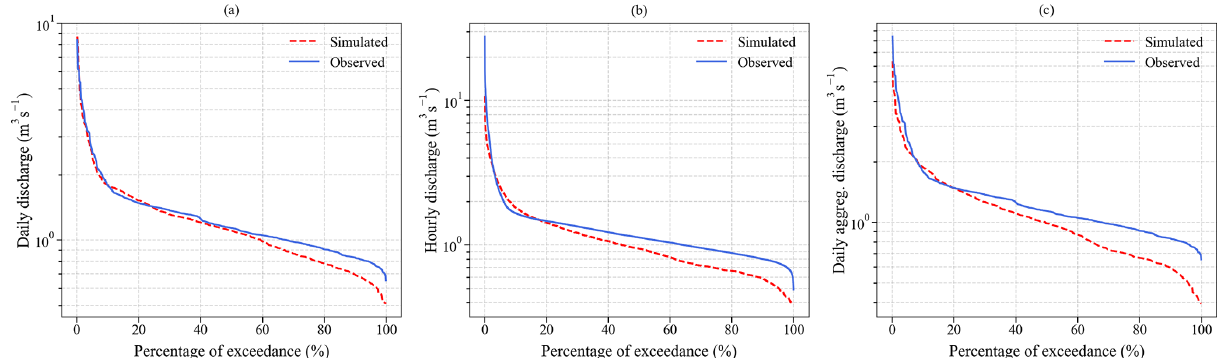
Figure 3. Observed and simulated flow duration curves (m 3 s − 1 ) at the daily time step (a) , at the hourly time step (b) , and at the daily discharge aggregated from hourly outputs time step (c) . Table 5. Model evaluation statistics of the daily, subdaily, and daily aggregated from hourly output SWAT models for the calibration and validation periods. Time step Period p factor r factor R 2 NSE PBIAS (%) Daily Calibration Validation Subdaily Calibration Daily averages Calibration